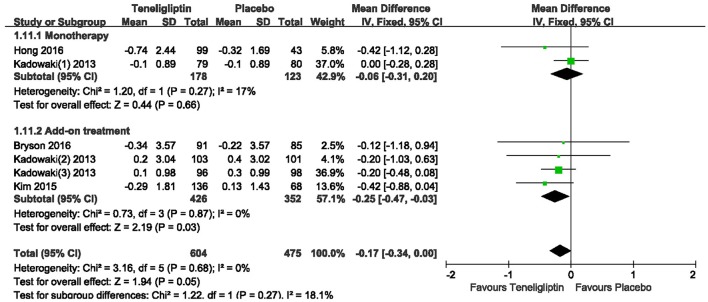
Effects of teneligliptin and placebo on HOMA-IR change from the baseline by meta-analysis.